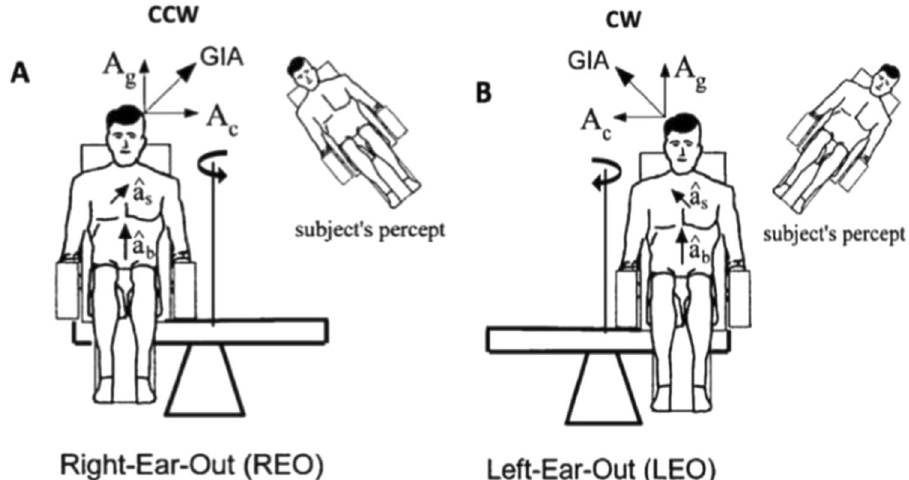
Fig. 3 The rotation axis is placed next to the subject, meaning that both otoliths will be simultaneously stimulated by GIA. A When the subject was moving according to the counterclockwise (CCW) direction, a virtual tilt of 45° was experienced to the right (right-ear-out, REO). B When the subject was moving according to the clockwise (CW) direction, a virtual tilt of 45° was experienced to the left (left-ear-out, LEO) 6,46 (From Moore, 2001 46 with permission; reproduced from Experimental Brain